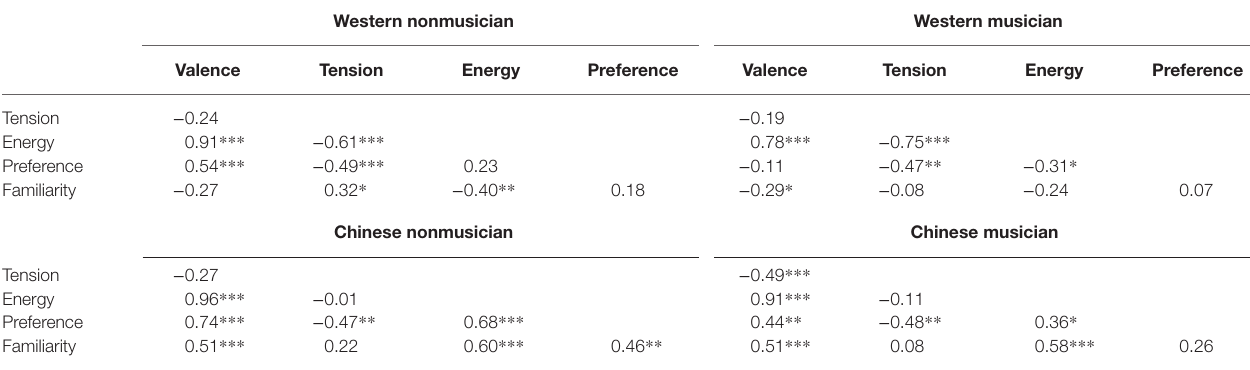
Chinese nonmusician Chinese